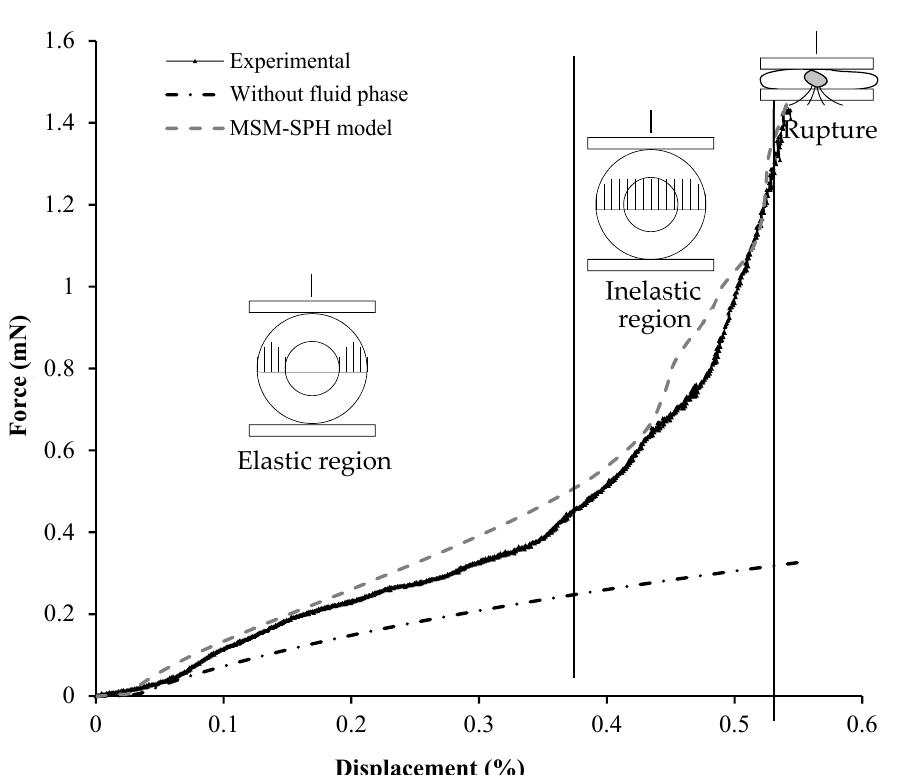
Figure 4. Force–displacement curve obtained from a laboratory parallel plate compression test for a single core–shell capsule, from a simulated single core–shell capsule without fluid inside and from a simulated single core–shell capsule. The upper plate displacement was expressed in %, taking into consideration the initial y -axis dimension of the capsule.